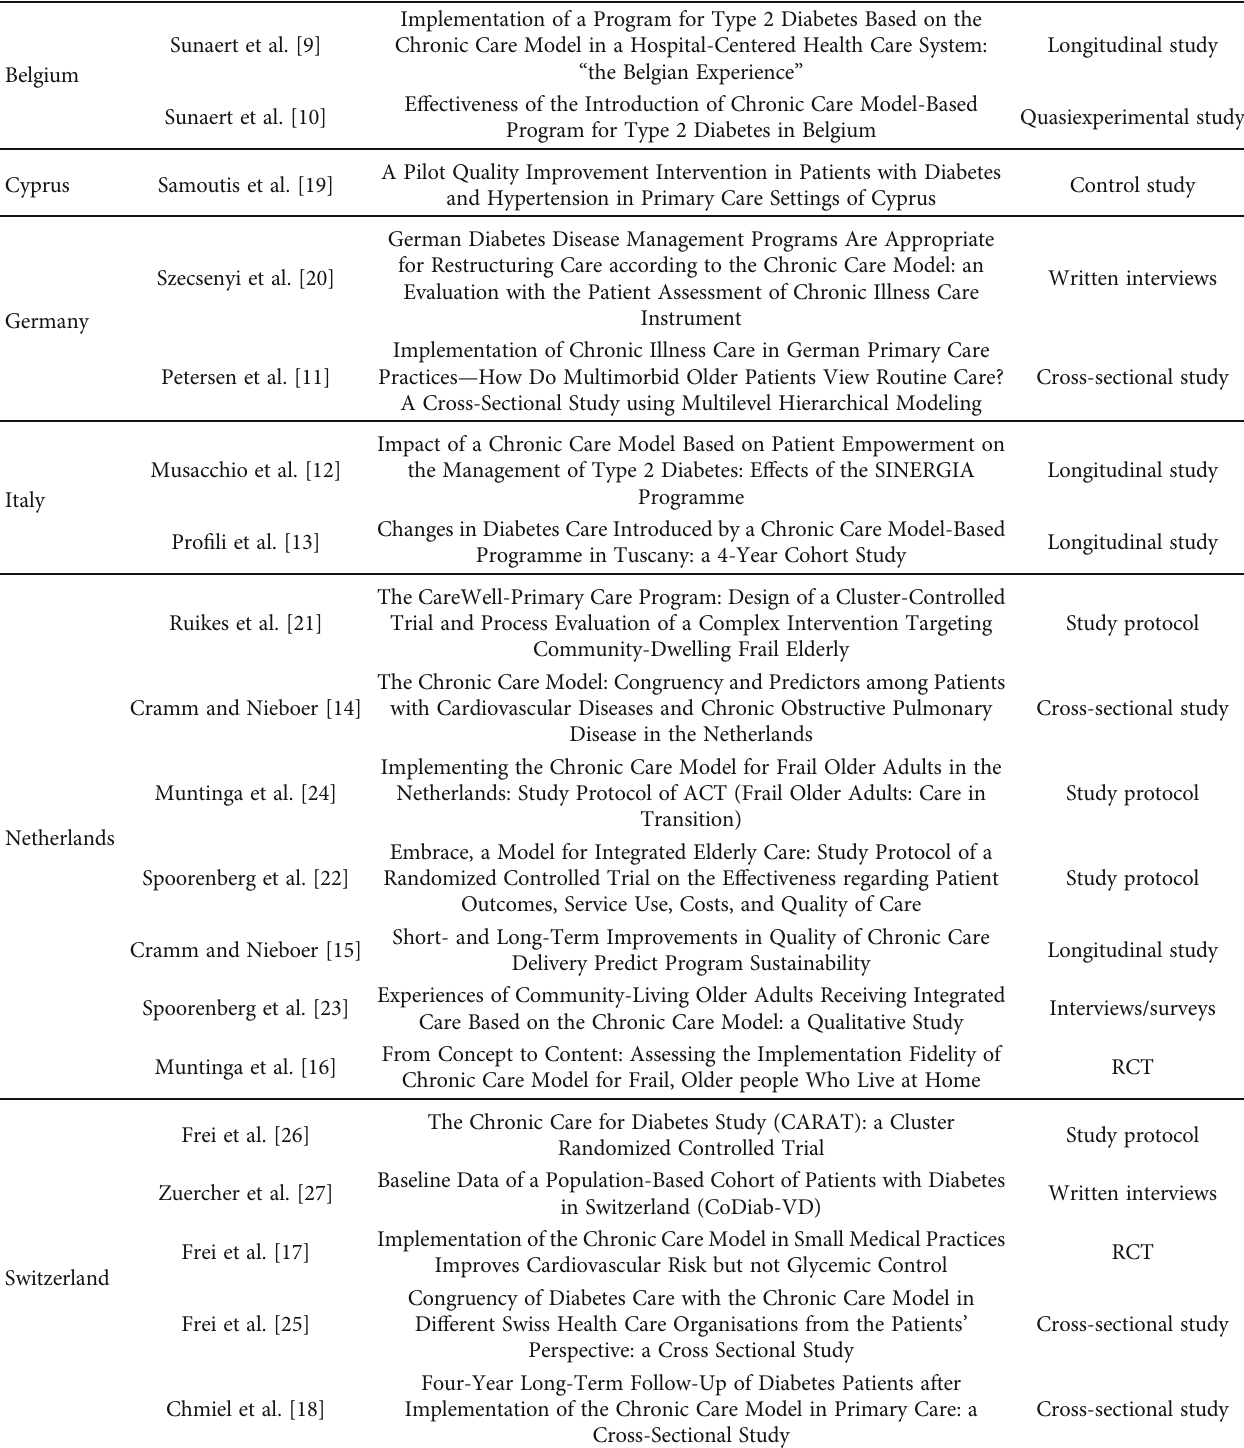
Table 2: Presentation of the articles according to country and study